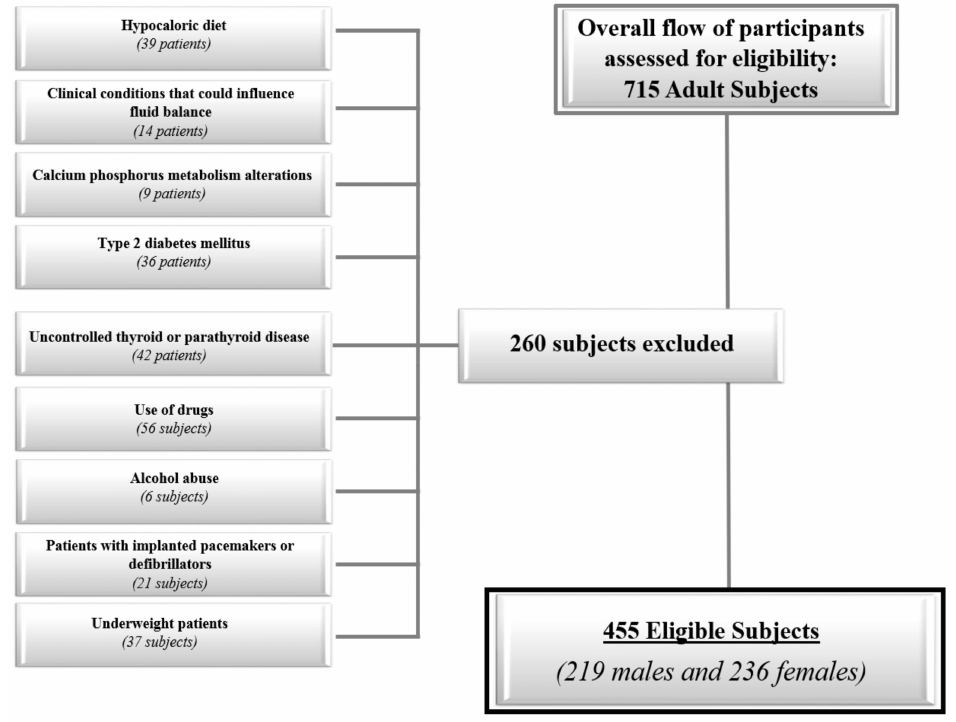
Figure 1. The flow chart of the study